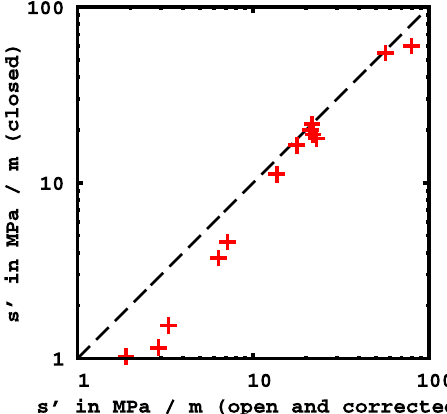
0 measured with closed bound- ary, against dynamic stiffness measured with open boundary plus correction; line of equality (dashed).